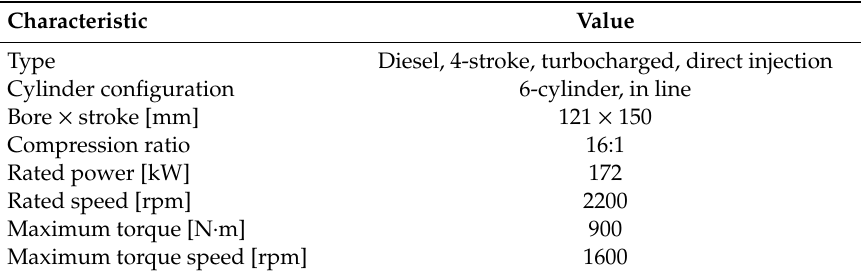
Table 1. Engine technical